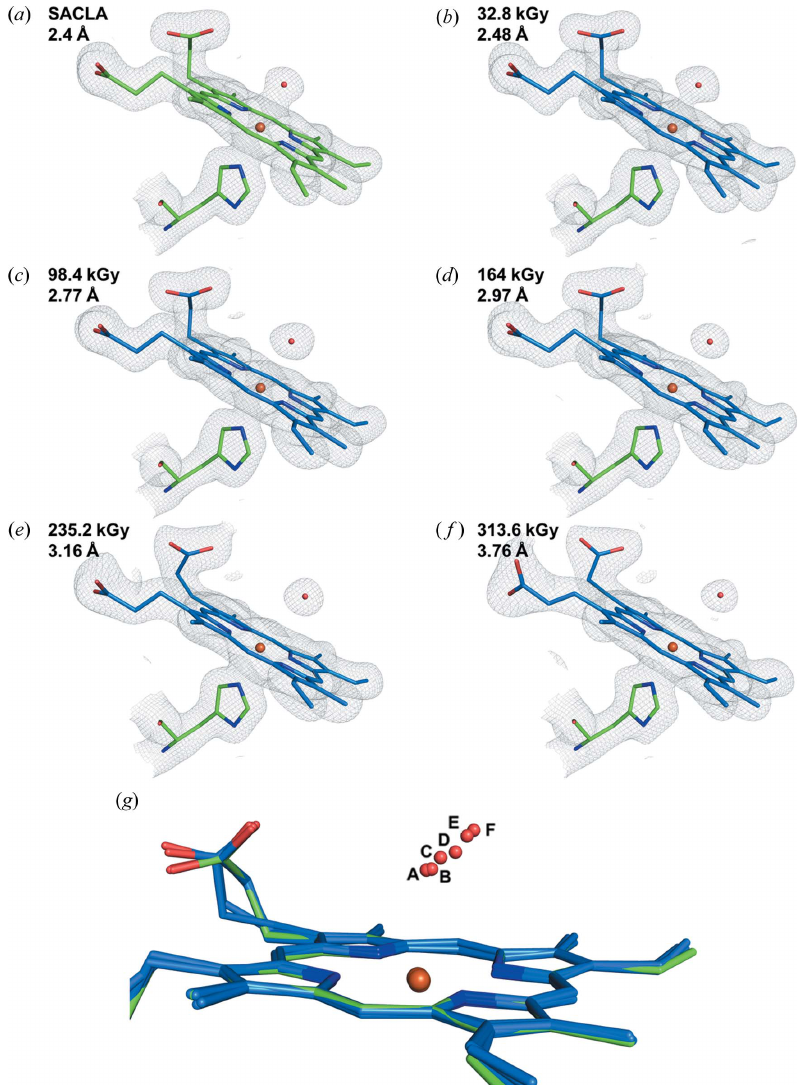
Figure 3 2 F o – F c electron-density maps contoured at 1 (cid:5) for the heme environment of DtpAa in ( a ) the SFX dataset from SACLA and ( b – f ) selected structures from the two MSS series. ( g ) Superposition of selected structures revealing the dose-dependent migration of the water molecule W1 away from the heme Fe. The SFX structure is shown in green with MSS in